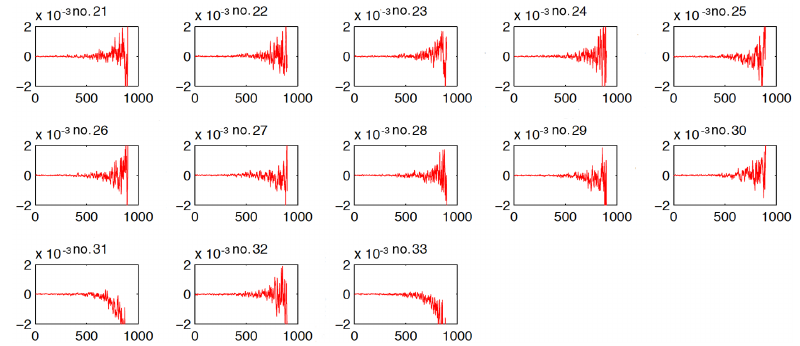
Figure 14. The subplot x axes represent the 900 EOFs. The y axes indicate the magnitude of the temperature variance. The ensemble member number is indicated in each subplot title, and members 31 and 33 have been subjected to lossy